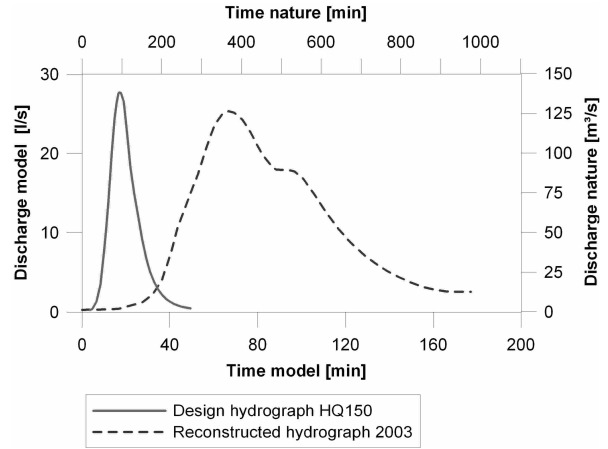
Fig. 4. Model hydrographs (solid line: Scenario 1 and 2, dashed line: Scenario